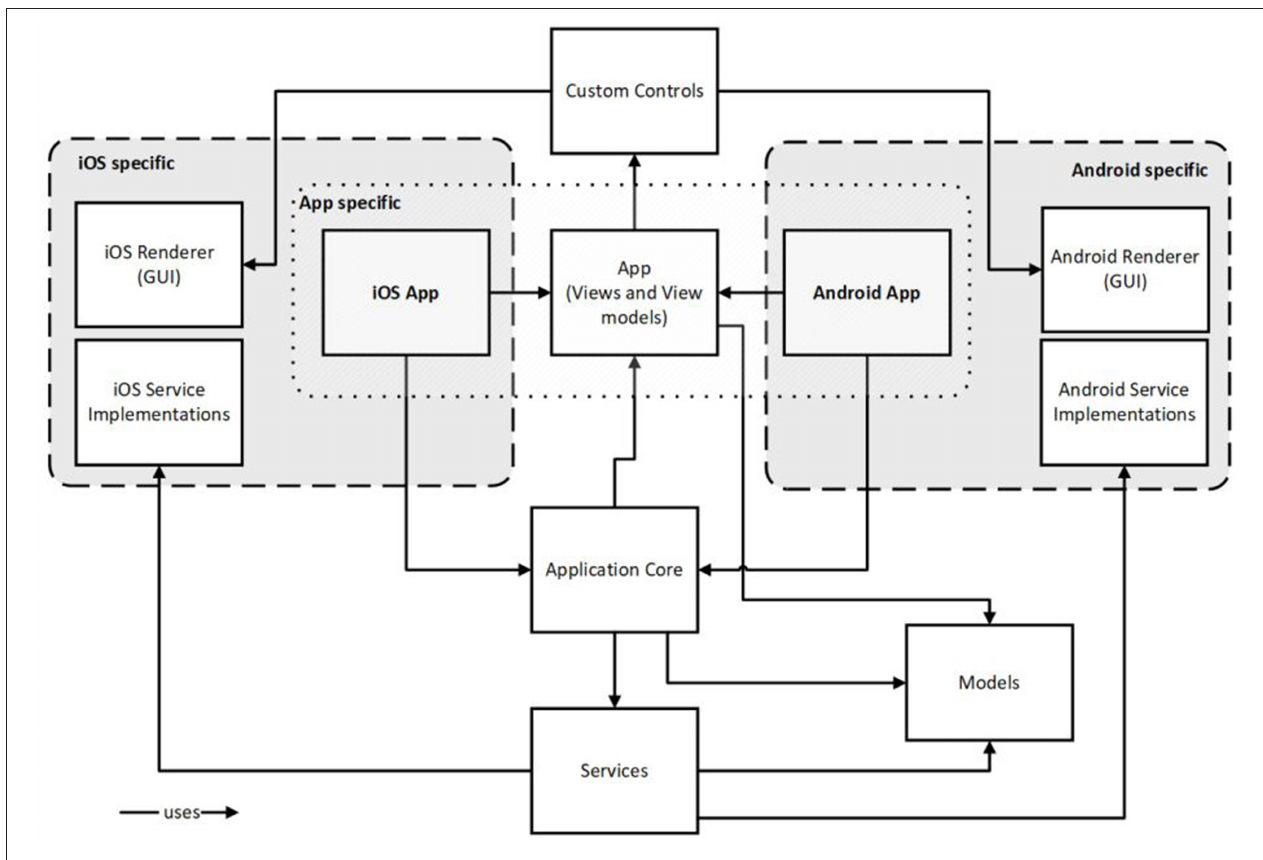
FIGURE 9 | Software architecture of the mobile app.